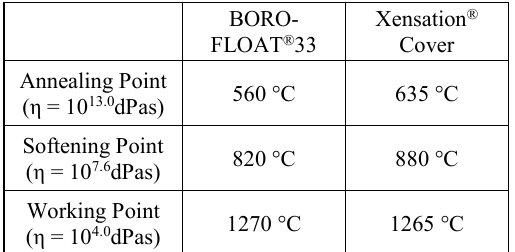
Table 1. Viscosity fixed points of the glass materials used.